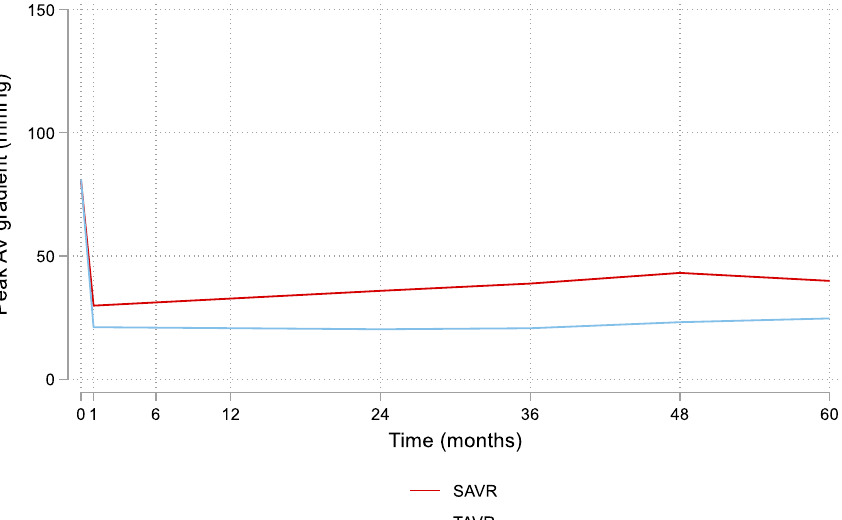
Fig. 4 Change in the peak aortic valve pressure after SAVR compared to TAVR (SAVR, surgical aortic valve replacement; TAVR, transcatheter aortic valve